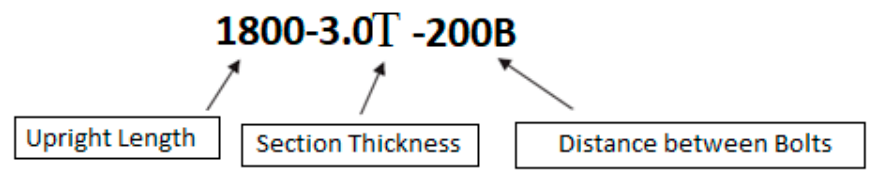
Figure 7. Designation of models